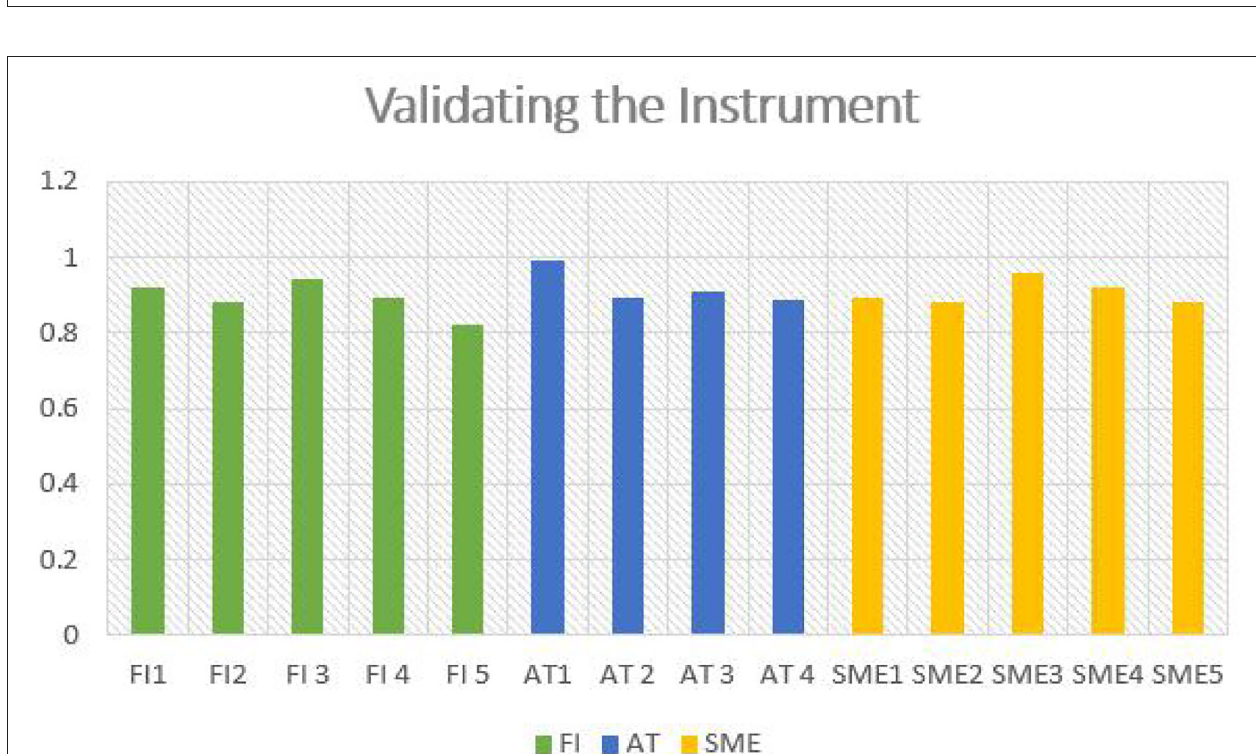
FIGURE 2 | Graphical representation of demographic details of respondents.